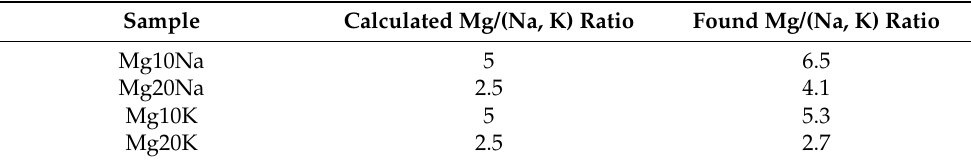
Table 2. Mg/(Na, K) ratios according to EDX in comparison with the calculated values.